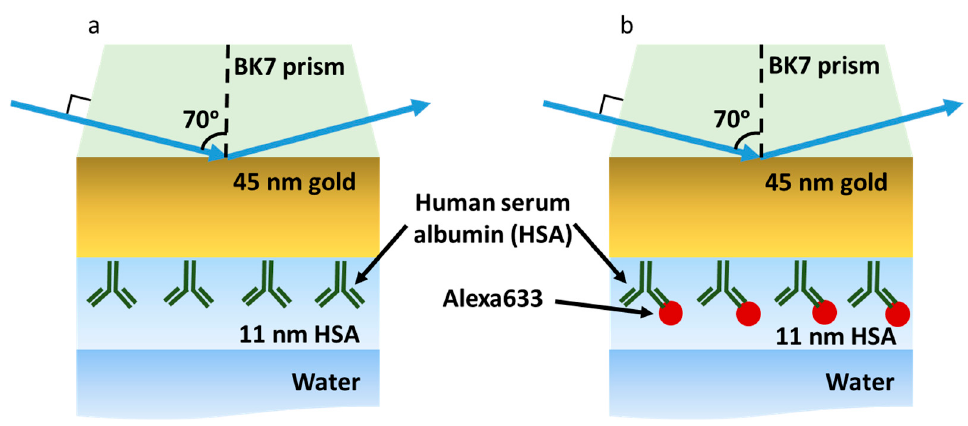
Figure 1. The schematic representation of the two modeled structures: ( a ) BK7/Au (45 nm)/HSA and water and ( b ) BK7/Au (45 nm)/HSA ‐ Alexa633 and water.